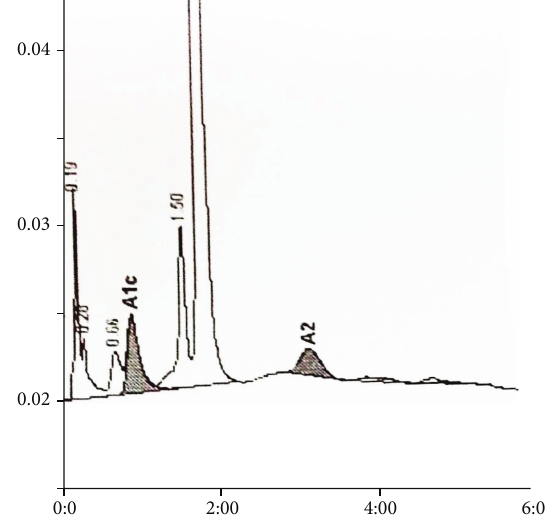
Figure 1: A1c of 4.7% at retention time of 0.87 minutes in a normal chromatogram.